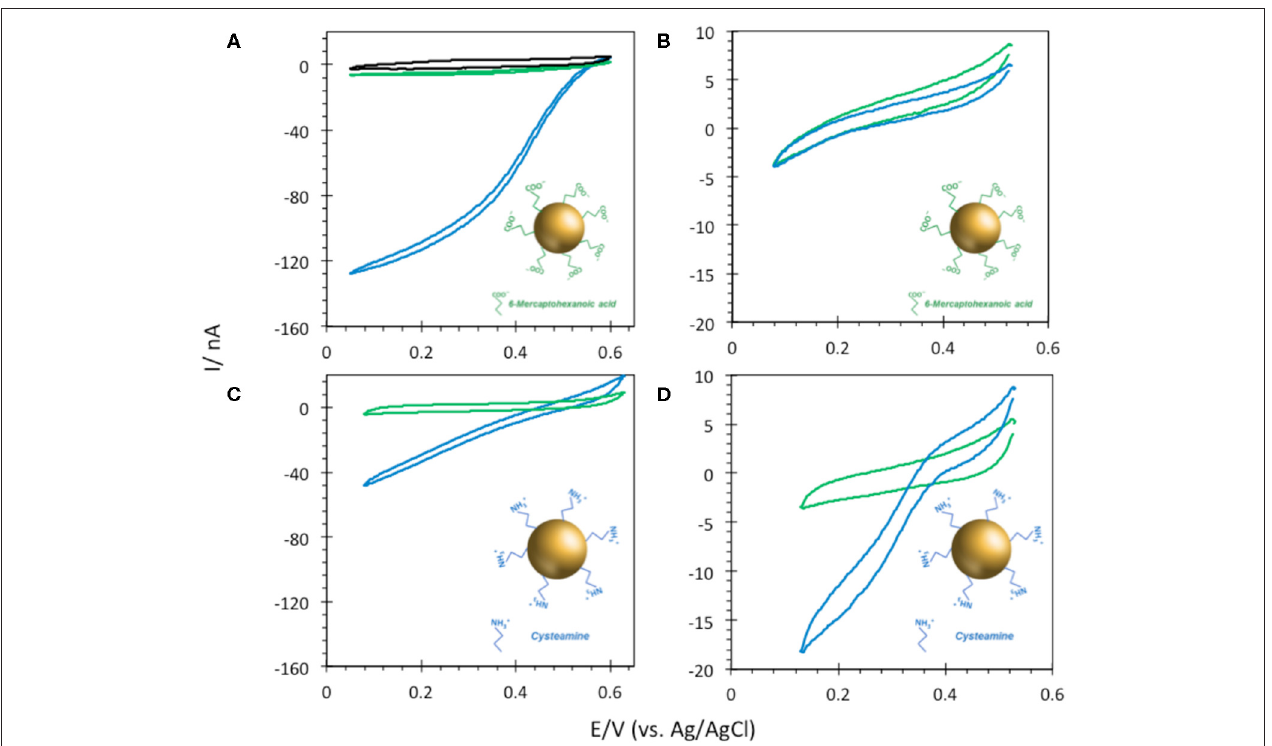
FIGURE 8 | CVs obtained under N 2 (green) and O 2 (blue) on (A,B) 6-MHA and (C,D) CYST functionalized AuNP@ITO (from Au film thickness of 30nm) electrodes with adsorption of Mv BOD (A,C) or Tt LAC (B,D) . In (A) the black curve corresponds to CV under O 2 of AuNP@ITO in the absence of enzyme. Scan rate 10 mV/s, 100mM phosphate buffer pH 6 for Mv BOD, and acetate buffer pH 5 for Tt